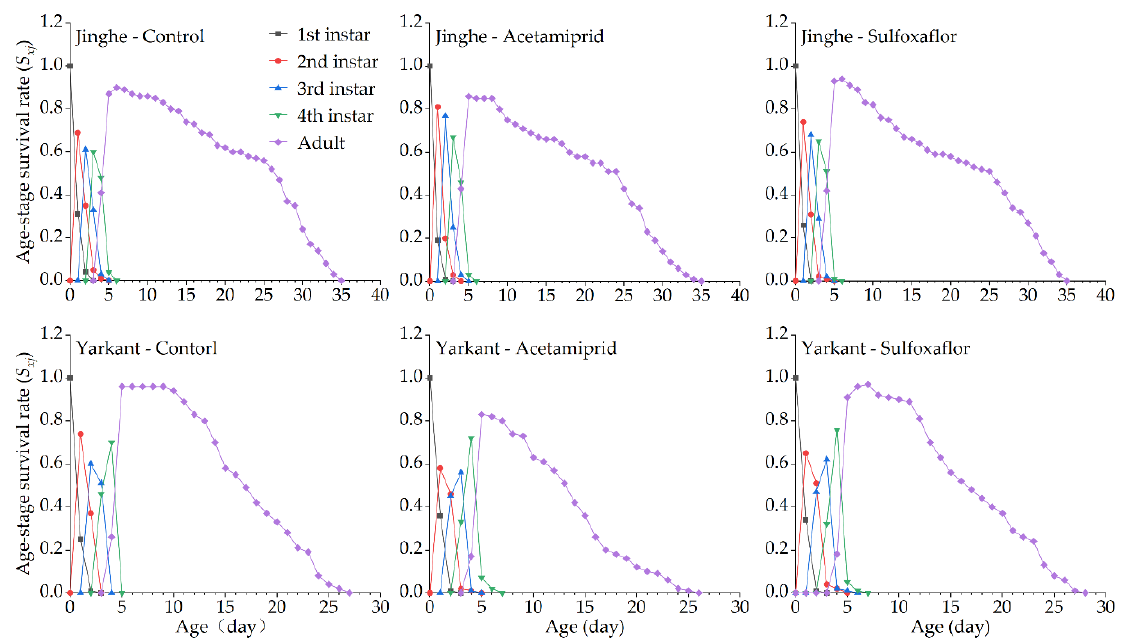
Figure 5. Effects of sublethal concentrations (LC 25 ) of acetamiprid and sulfoxaflor on the age-stage specific survival rate ( S xj ) of A. gossypii of the F 2 generation in Yarkant and Jinghe.